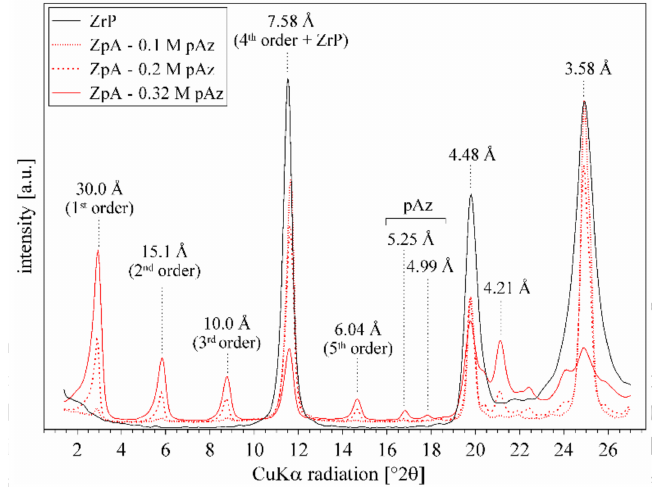
Figure 4. XRD pattern of ZrP and ZpA samples obtained with different pAz loadings (0.1, 0.2, and 0.32